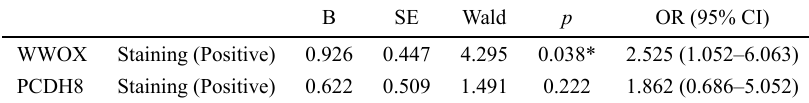
Table 3. Logistic regression analysis of predictive factor for predicting PCa.